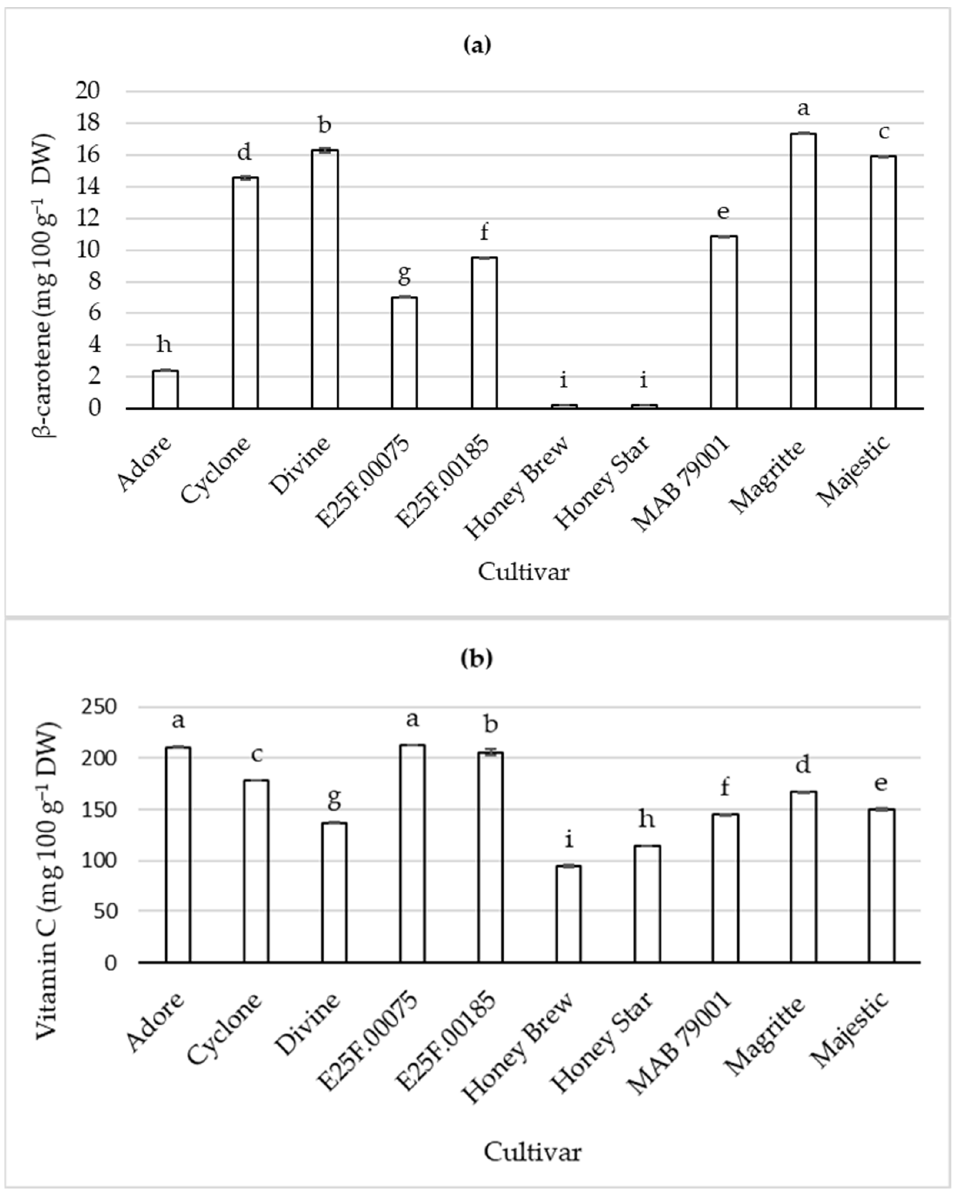
Figure 1. β -Carotene ( a ) and vitamin C ( b ) contents of fruit from sweet melon cultivars at harvest. Bars (with error bars indicating standard error of means) with different letters are significantly different at p ≤ 0.05 (Fisher’s protected LSD test, n = 4). DW = dry weight.